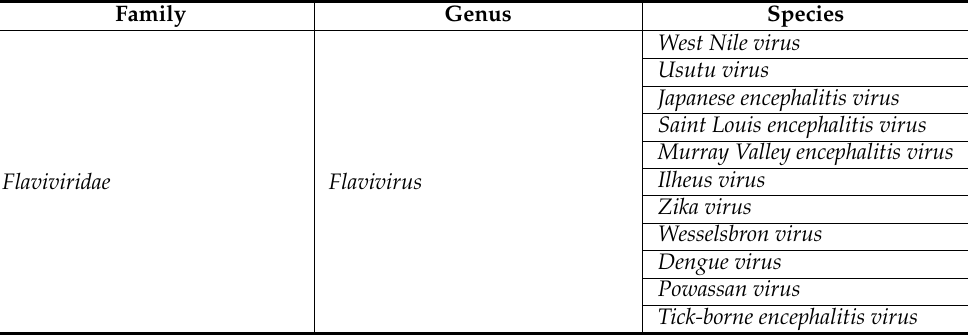
Table 1. Flaviviruses known to cause neurological disease in